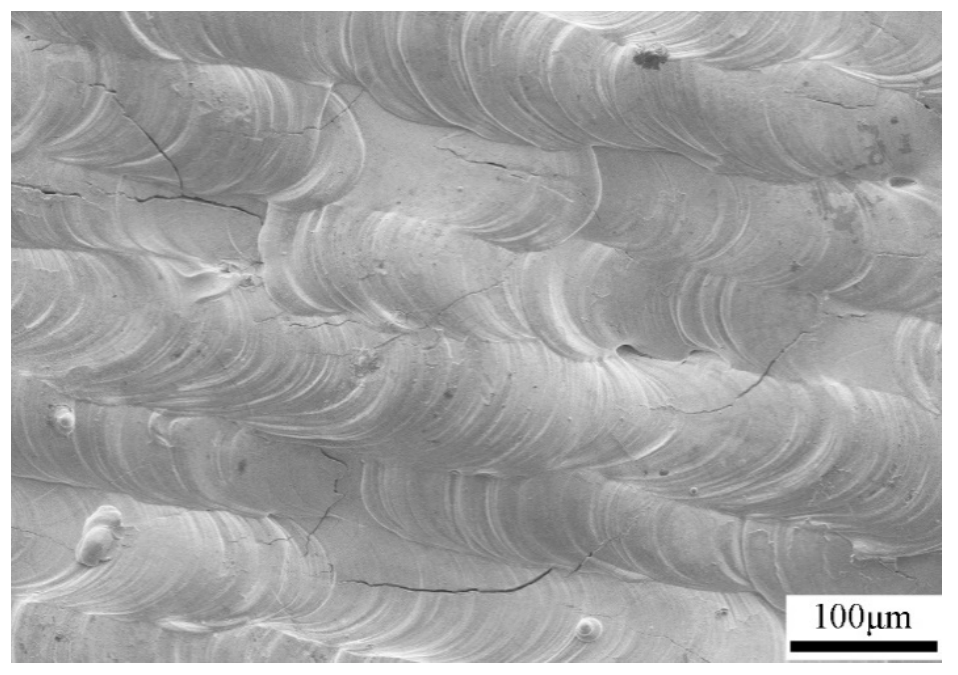
Figure A1. Microcracks on the top surface.